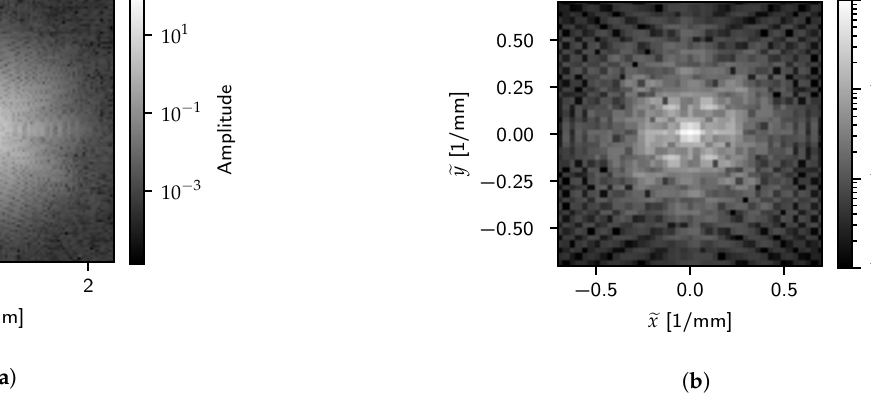
Figure 20. FFT of color gradient magnitude for the elliptical case over ( a ) the total frequency domain and ( b ) a low-frequency domain.